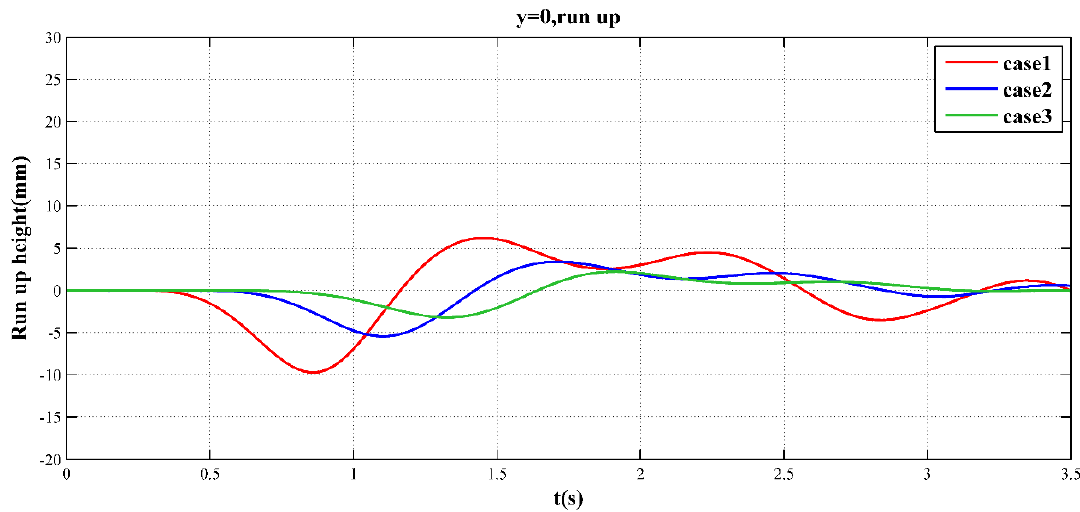
Figure 9. Time series of run-up heights at y = 0.